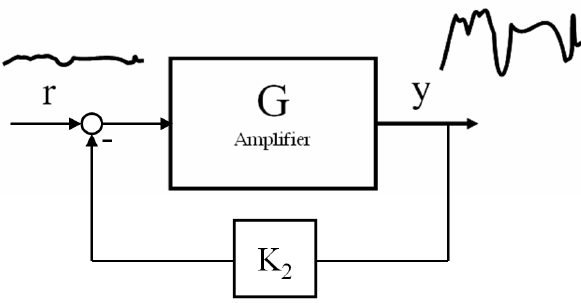
Figure 1: Solution 1 (feedforward): G = k = a (ad- justable).